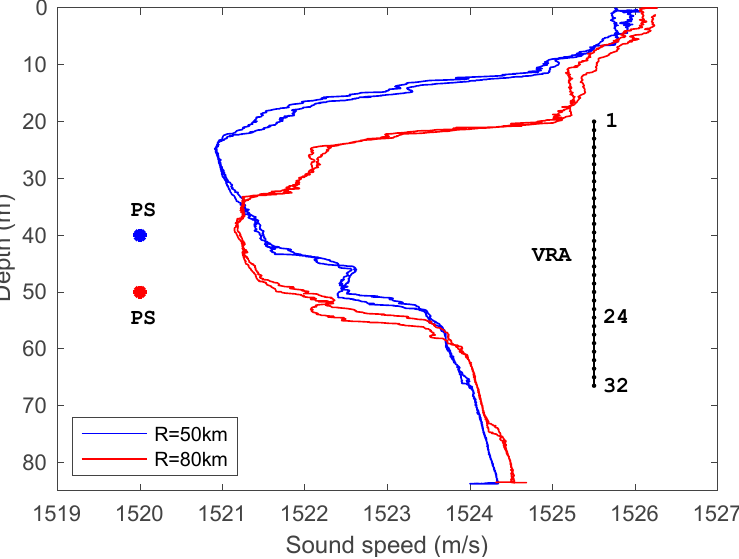
Figure 2. The sound speed profiles measured during the experiment along with the depth coverage of the VRA and the depths of the probe source.